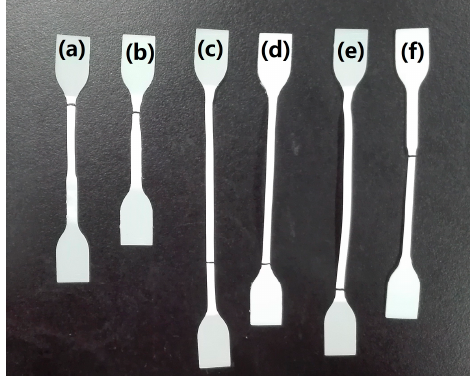
Figure 8. Optical photograph of the tensile-fractured specimens: ( a ) Quenched PLA/TPEE (80/20) specimen with X c of 4%; ( b ) Annealed PLA/TPEE (80/20) specimen with X c of 40%; ( c ) Quenched PLA/TPEE/ADR (80/20/0.5) specimen with X c of 5%; ( d ) Annealed PLA/TPEE/ADR (80/20/0.5) specimen with X c of 36%; ( e ) Quenched PLA/TPEE/ADR (80/20/1.0) specimen with X c of 5%; ( f ) Annealed PLA/TPEE/ADR (80/20/1.0) specimen with X c of 34%.